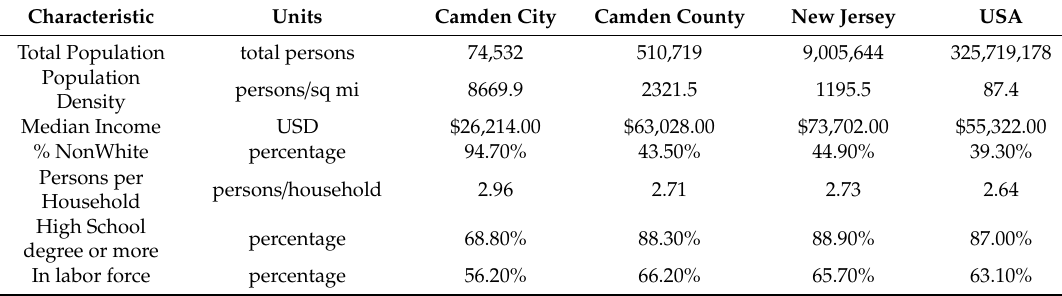
Table 2. Demographic characteristics by geography, 2017 estimates, US Census Quick Facts.